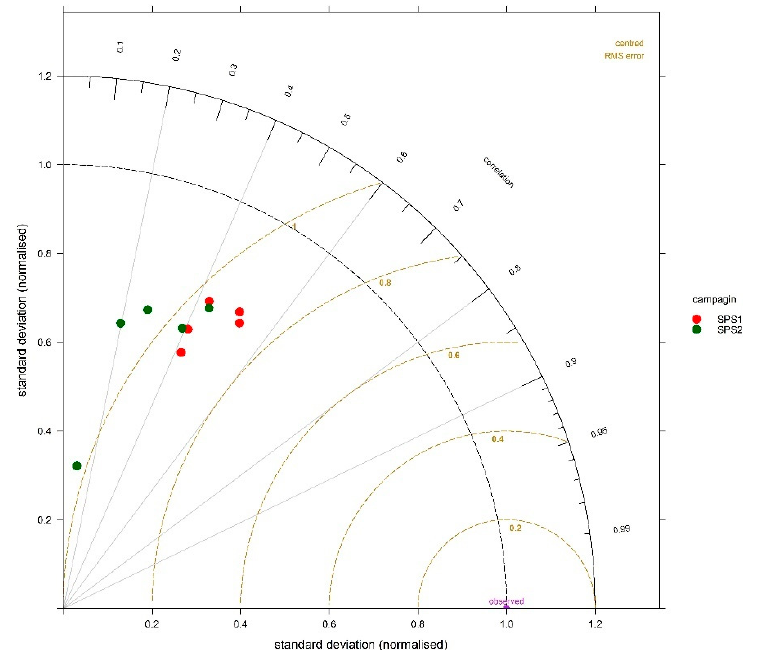
Figure 6. Taylor diagram of hourly PM 2.5 for all predicted/observed pairs of values at Chullora, Earlwood, Richmond, Liverpool and Wollongong stations for SPS1 (red dot) and SPS2 (green dot).